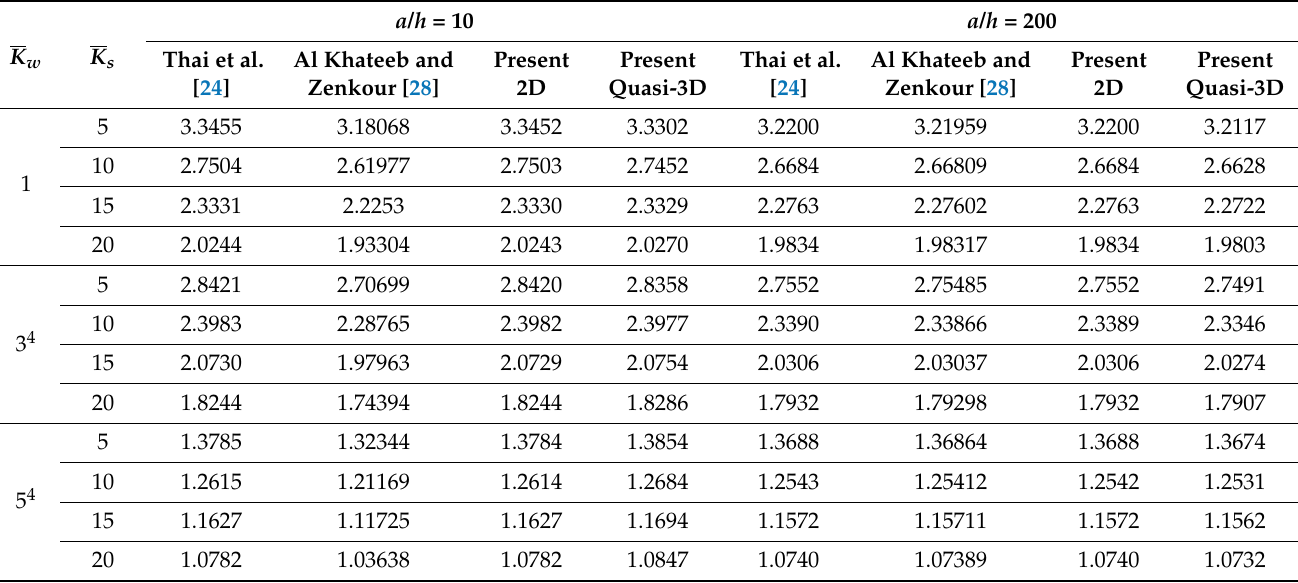
Table 8. Comparison of the dimensionless deflection w ∗ of isotropic square plate subjected to uniformly distributed load.